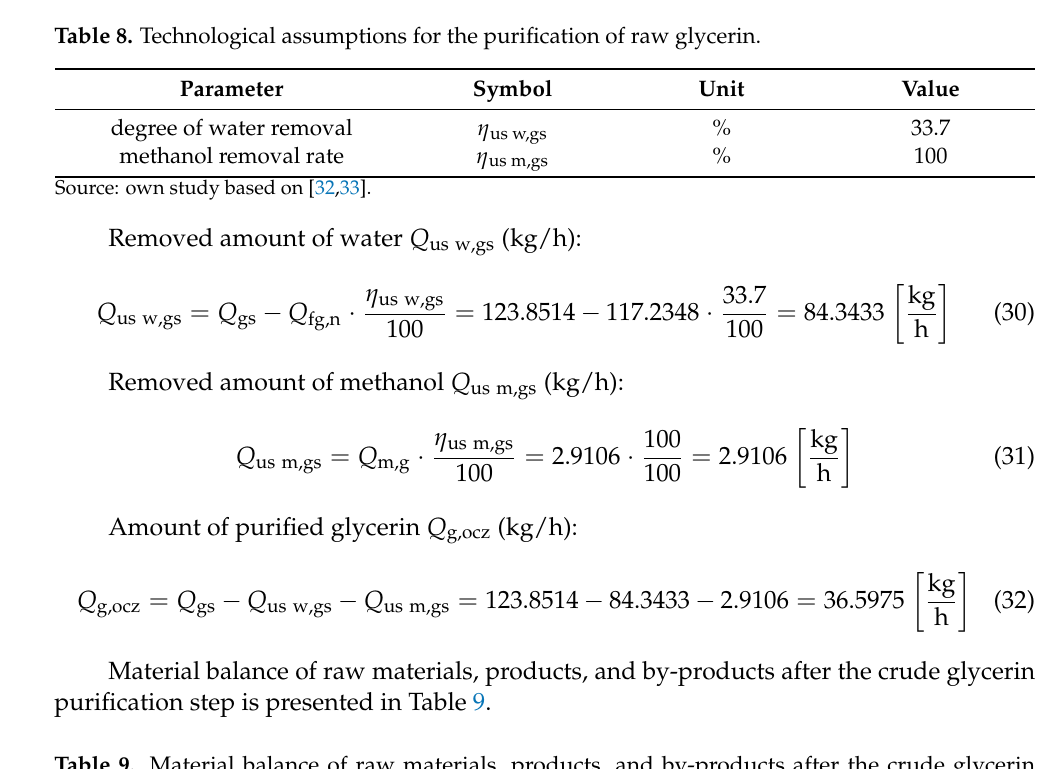
Table 9. Material balance of raw materials, products, and by-products after the crude glycerin purification